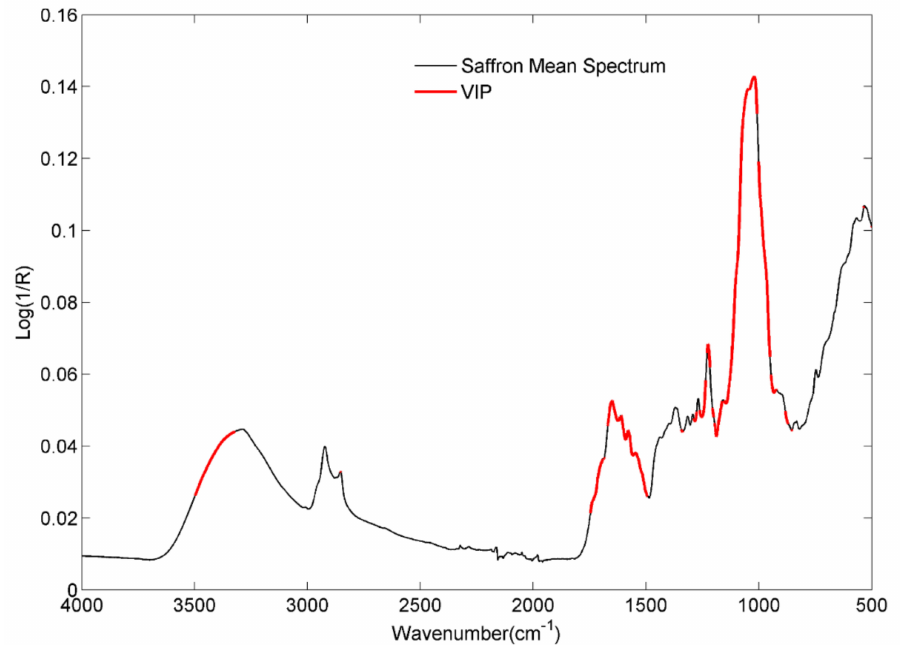
Figure 3. Mean saffron spectrum in black and significant spectral variables highlighted in